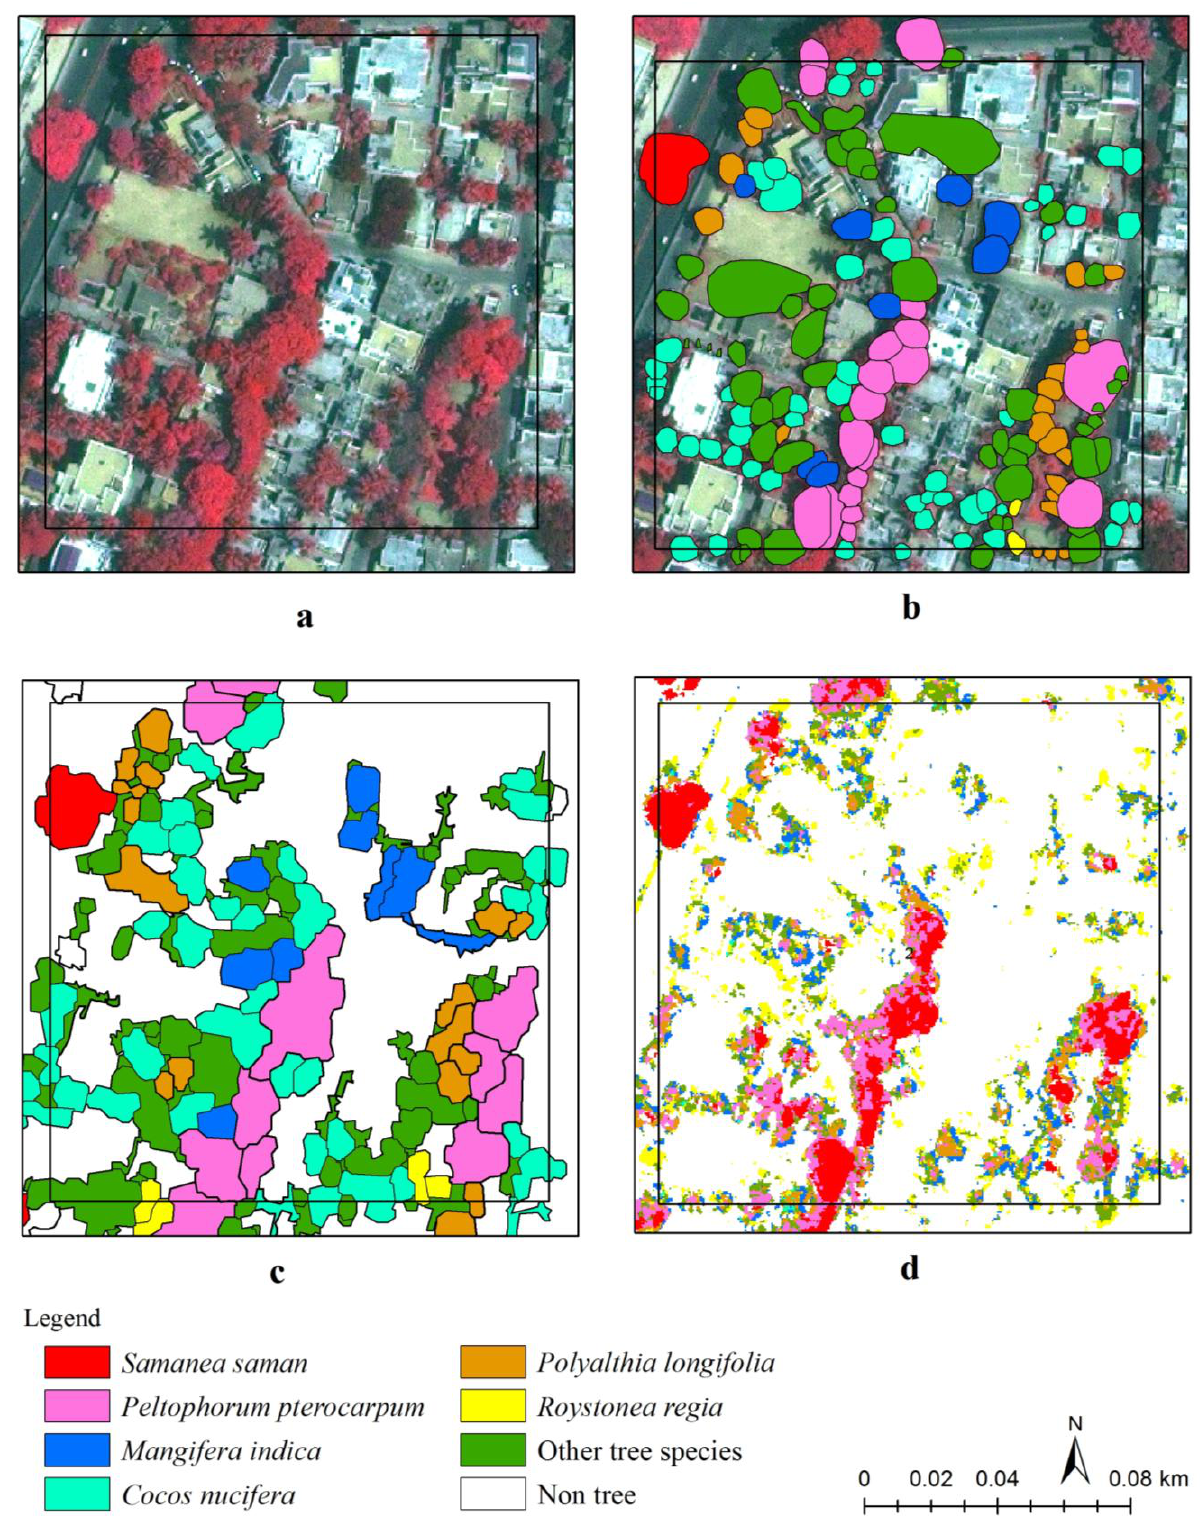
Figure 5. ( a ) False color composite of a grid cell along a residential neighborhood. ( b ) Tree species mapped from ground survey. ( c ) Tree species mapped using object-based approach. ( d ) Tree species mapped using pixel-based